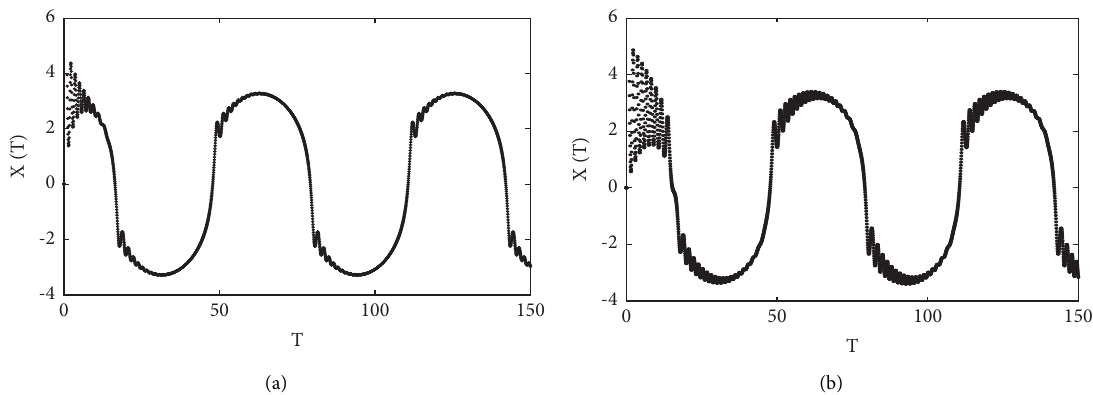
Figure 9: Numerical results of the amplitude jump in the plant-wind system for the parameters α � 0 . 675 and ω � 0 . 1. (a) Periodic state for F � 25 and ξ � 0 . 5. (b) Chaotic behavior for F � 27 and ξ � 0 . 1.